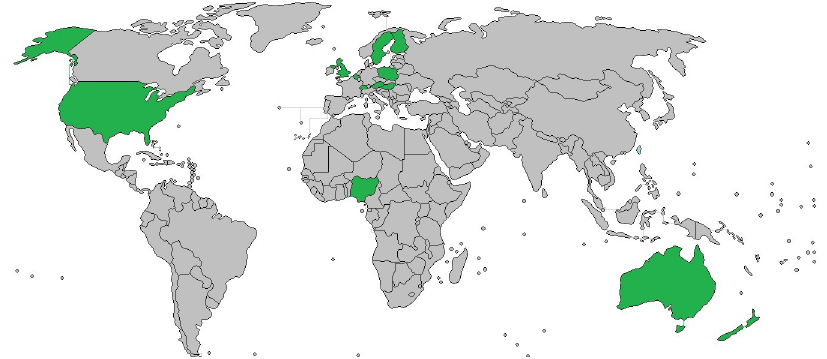
Fig 2. Countries that contributed to this meta-analysis.